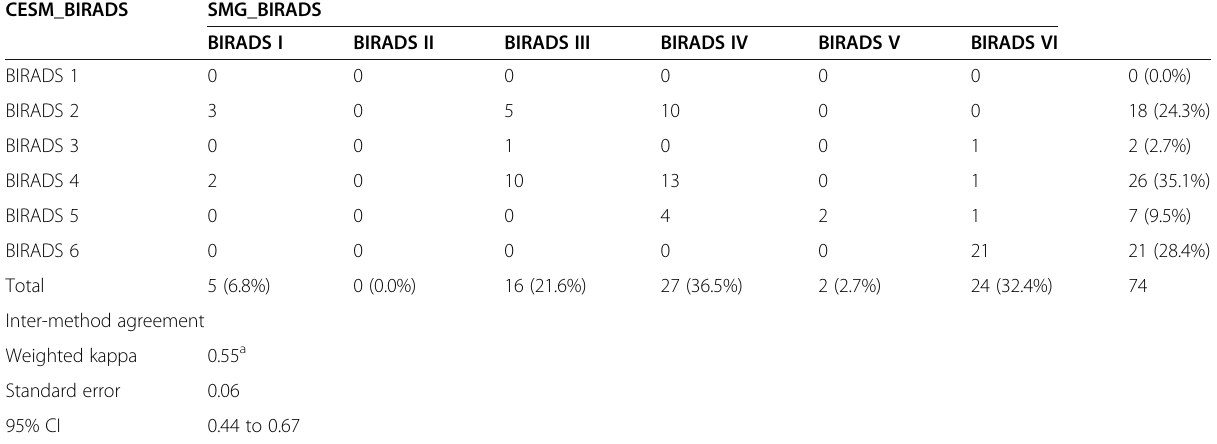
Table 12 Agreement between SMG and CESM as regards the BIRADS classification in patients with ACR grade C/D